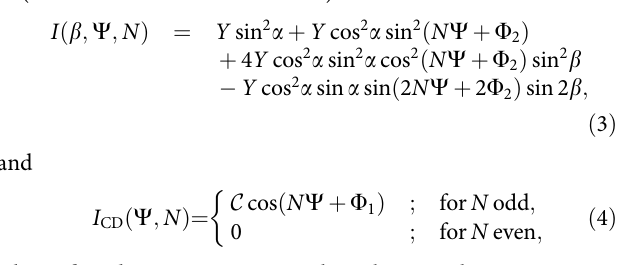
Numerical results . Figure 2e–h shows the numerical calculation results for the CD cross-section for different topological spin motifs. Equation (4) can be represented by the CD amplitude as a function of a closed-loop in reciprocal space. Each reciprocal , q diff ) on the loop (shown in red) corresponds to space point ( q diff x y one azimuthal angle at which the diffraction condition for the modulation wavevector for C is met. Therefore, according to equation (4), the CD intensity varies as a function of C , with a periodicity that is equal to N if the spin winding is an odd number. For even winding numbers, such as N ¼ 2, there is no CD. This can be understood by treating a N ¼ 2 skyrmion as